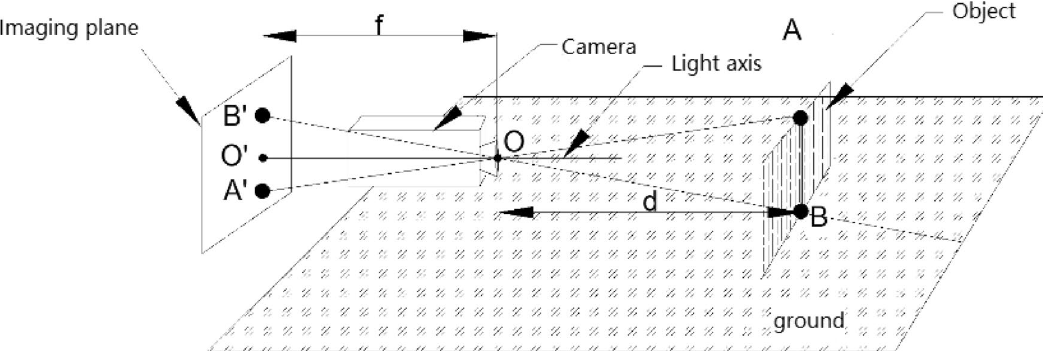
Fig. 2 Principle of crop height measurement